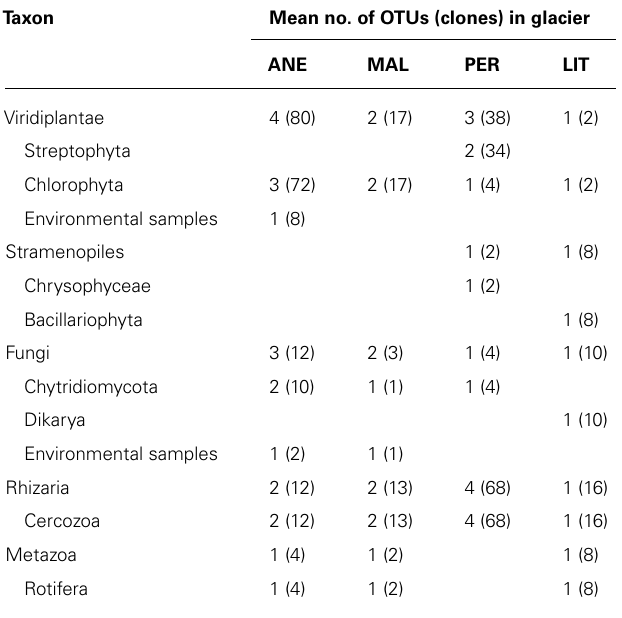
Table 3 | Diversity of small eukaryotes in clone libraries from glaciers. Taxon